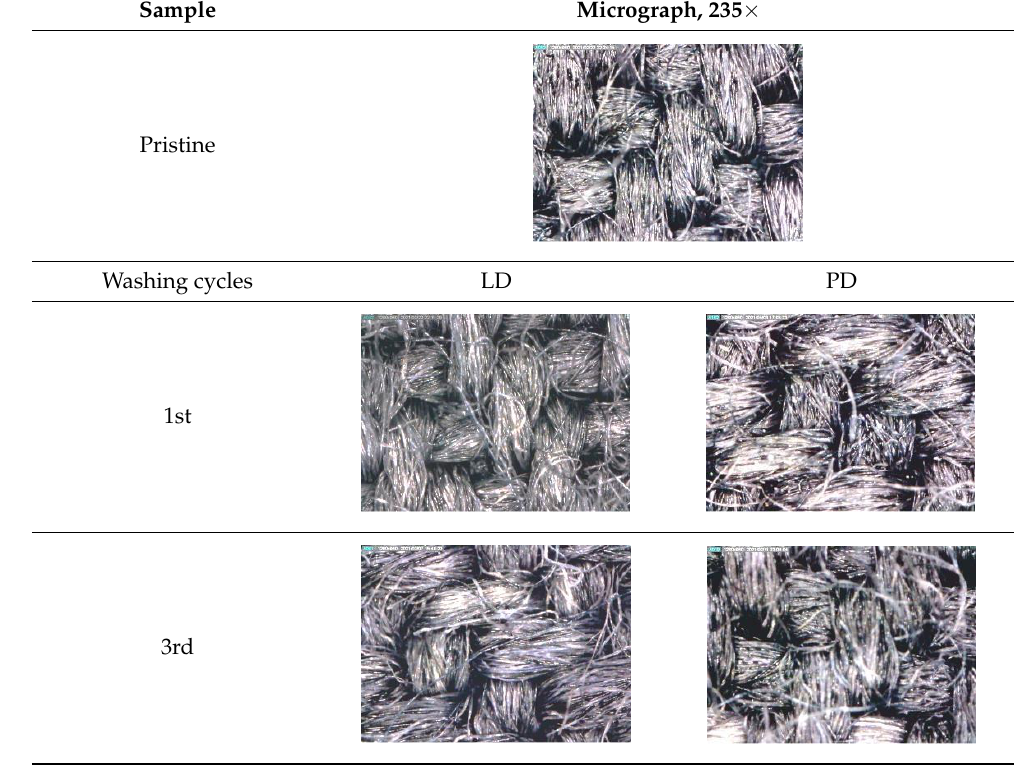
Table 4. Characterization of fabric surface before and after washing with liquid and powder detergents. Sample